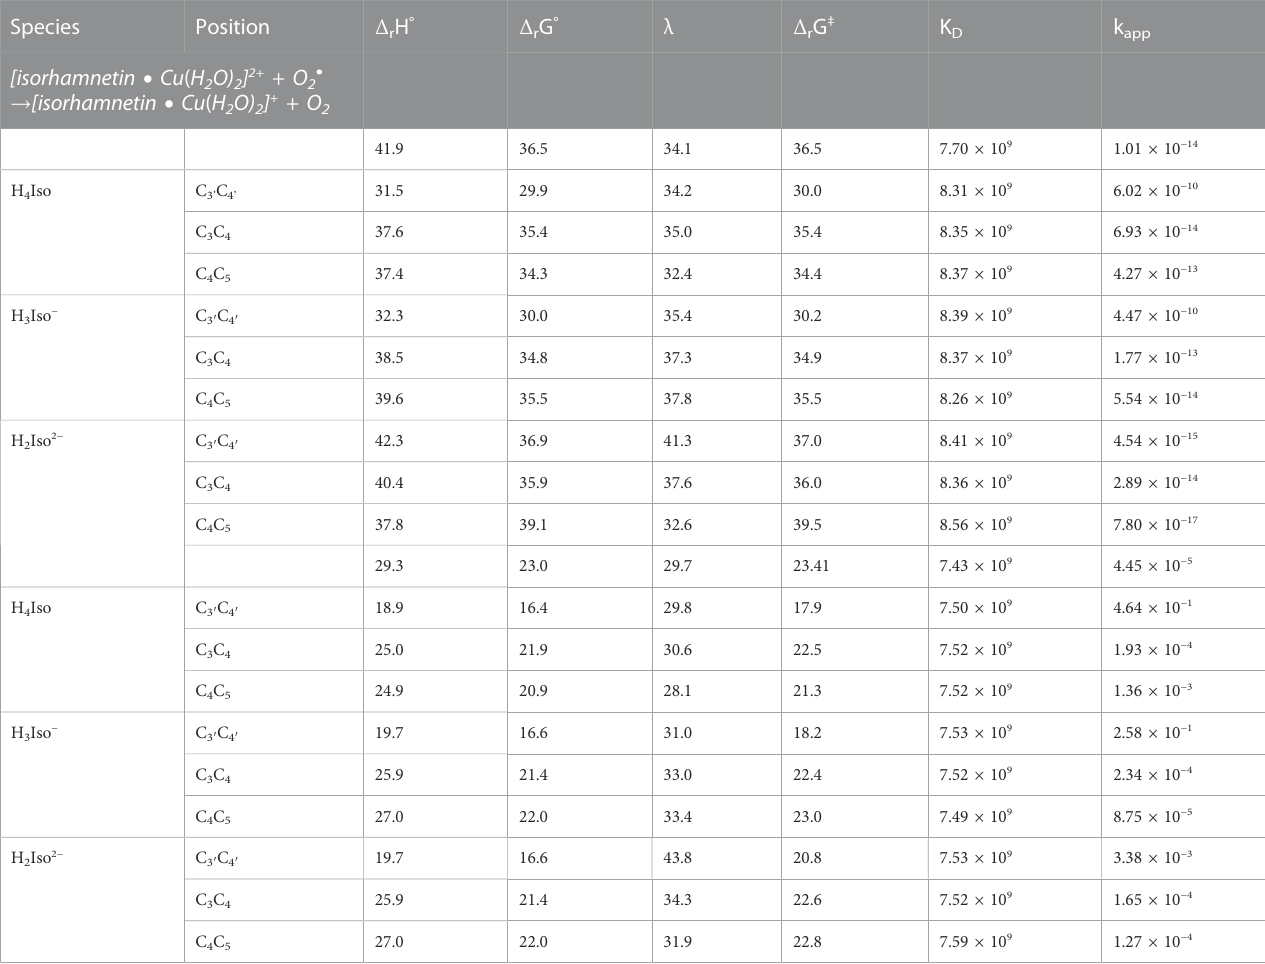
TABLE 7 The standard enthalpy ( Δ r H ° , kcal/mol), Gibbs free energy of reaction ( Δ r G ° , kcal/mol), reorganization energy ( λ , kcal/mol), Gibbs free energy of activation (